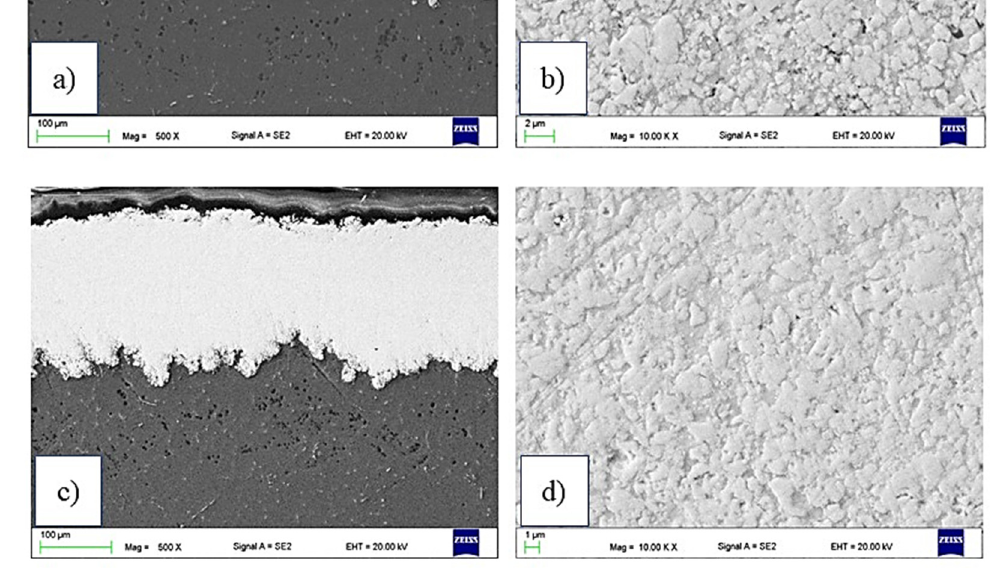
5 of 16 Figure 2. Morphology of: ( a ) P1, ( b ) P2, and ( c ) P3 powder (SEM). 3.2. Microstructure of the Coatings The detailed examination at high magnification (Figure 3b,d,f) revealed a dense structure with fine pores (much lower than 1 µm) and a typical low porosity level. This dense structure is due to the inherent characteristic of the HVOF process (mainly the high kinetic energy of the particles). In Figure 3b,d, the hard particles are homogeneously dis- tributed in the cobalt matrix, whereas for C3 (Figure 3f), there are some areas of nickel matrix islands without hard particles. This is similar to the phenomenon reported by [26– 28].